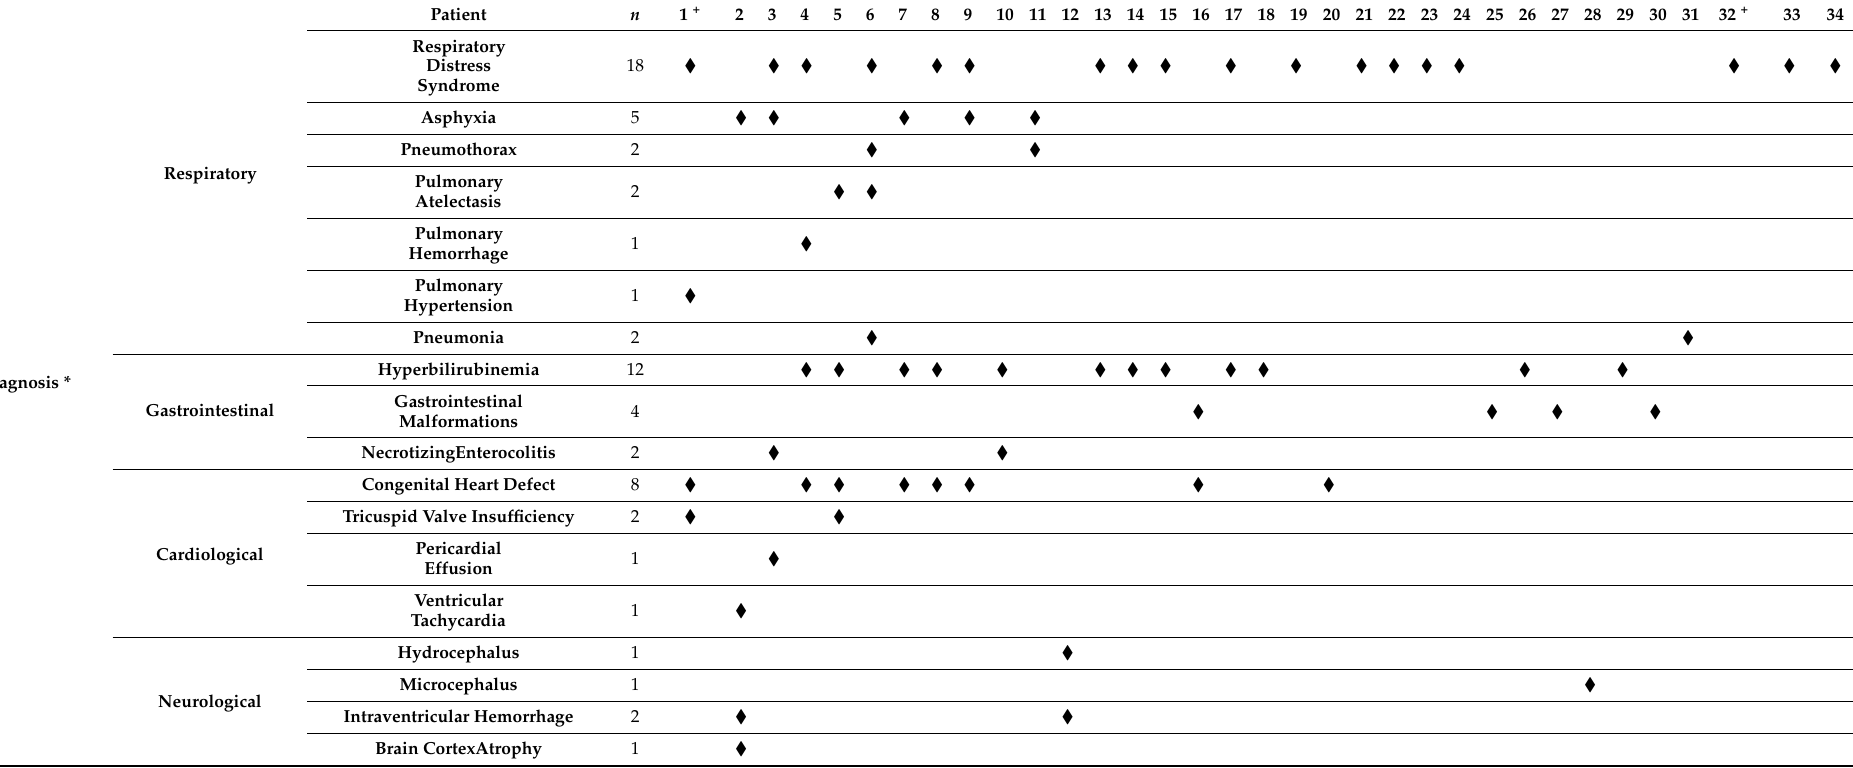
Table 1. Main causes of admission to the NICU of the studied preterm newborn population ( n = 34 patients).